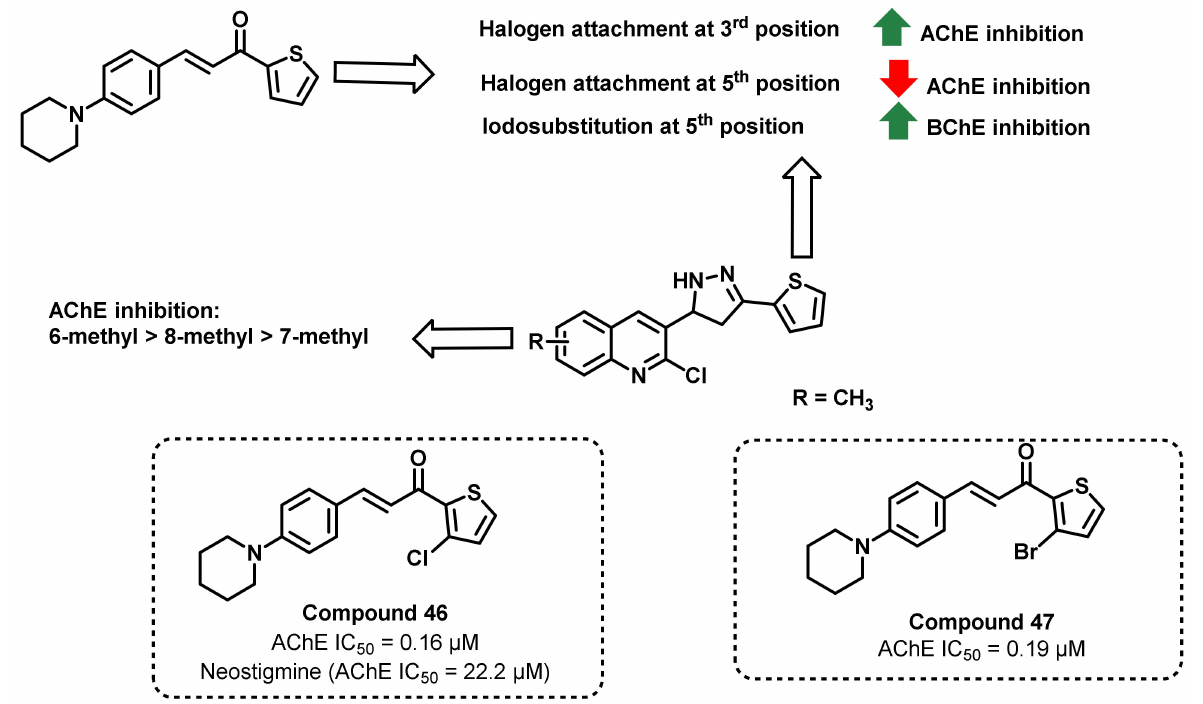
Figure 41. Piperidyl–thienyl and 2-pyrazoline derivatives of chalcone.